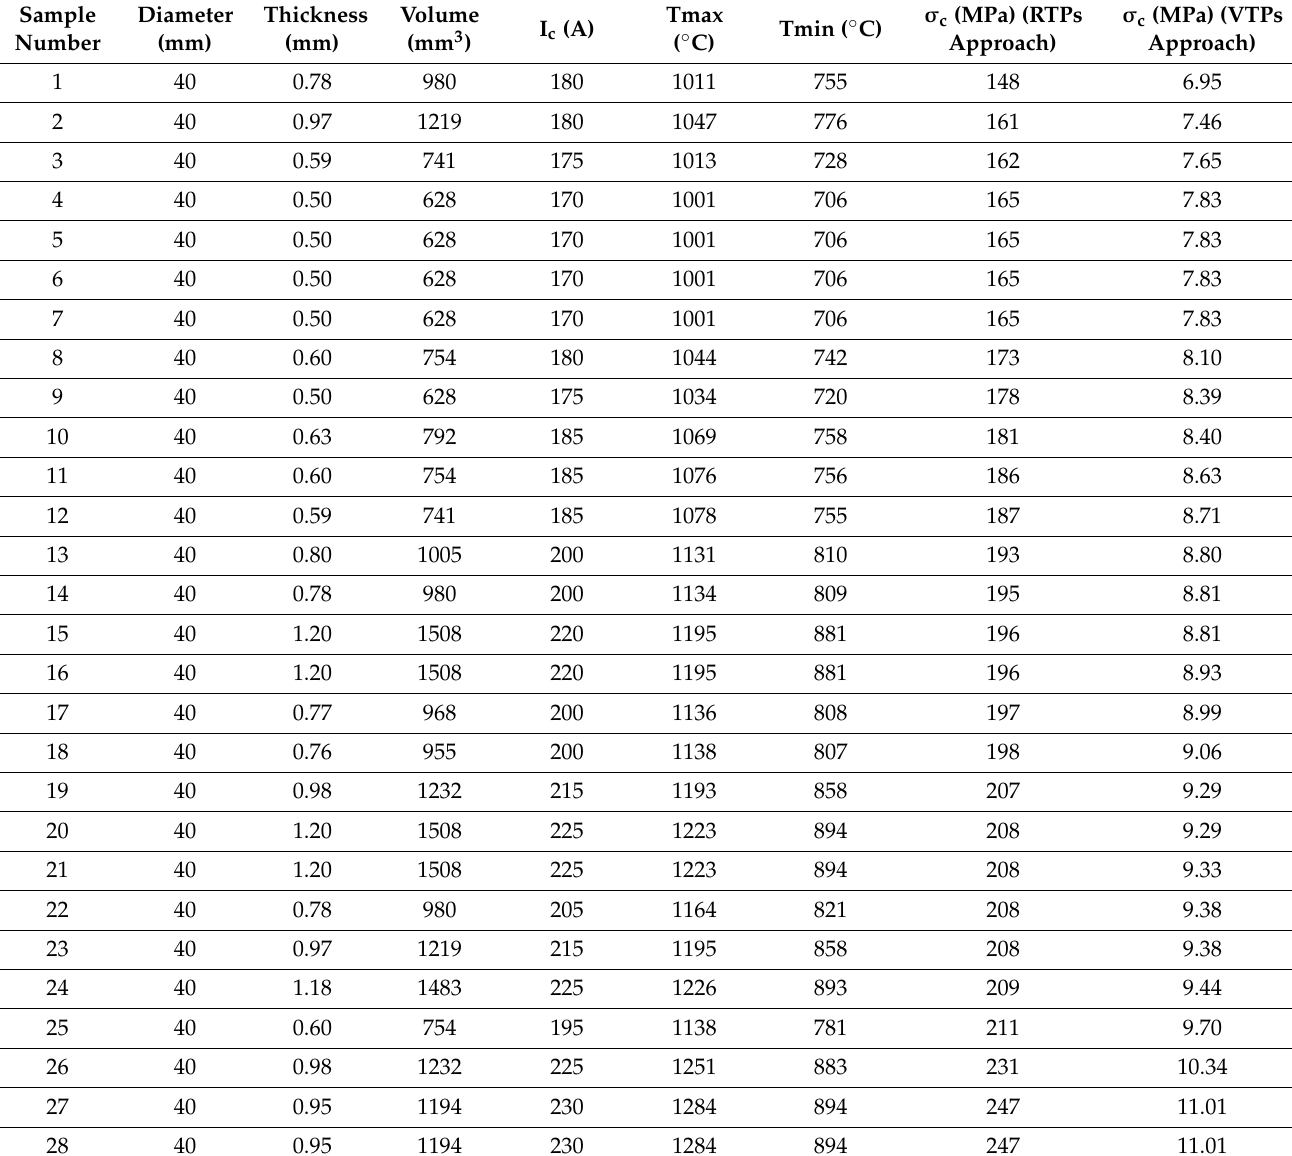
Table 5. SiC SP input data for Weibull statistical